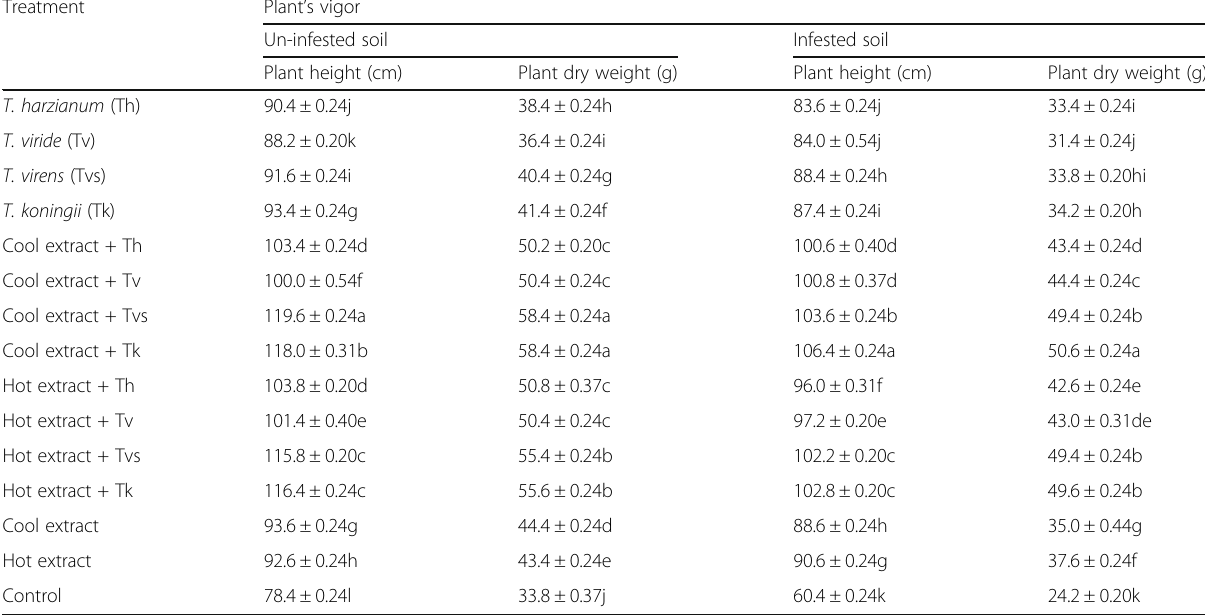
Table 5 Effect of Trichoderma spp. alone or in combination with Chlorella vulgaris extract on maize plant growth characters under infested and un-infested soil with Cephalosporium maydis